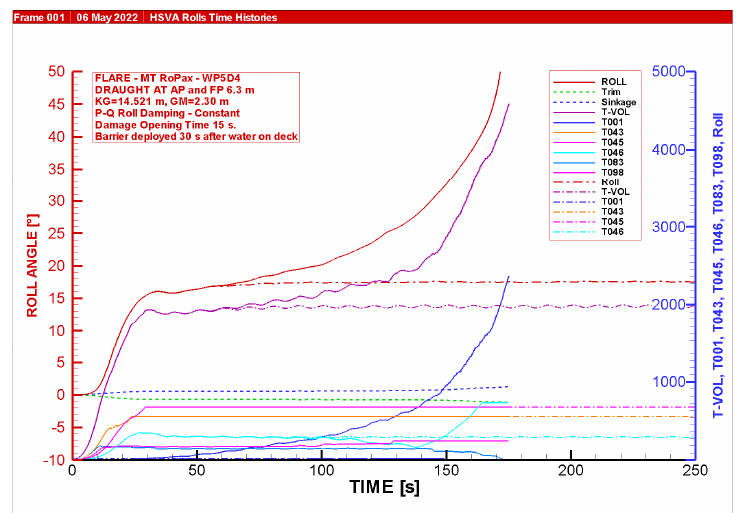
Figure 17. Deployable barrier (in 30 s) with damage opening time 15 s: The roll angle (red) and water volumes on trailer deck (deep blue) and in damaged compartments. The solid curves show the sit ‐ uation without the deployed barrier, the dash ‐ dotted ones the results with the barrier.